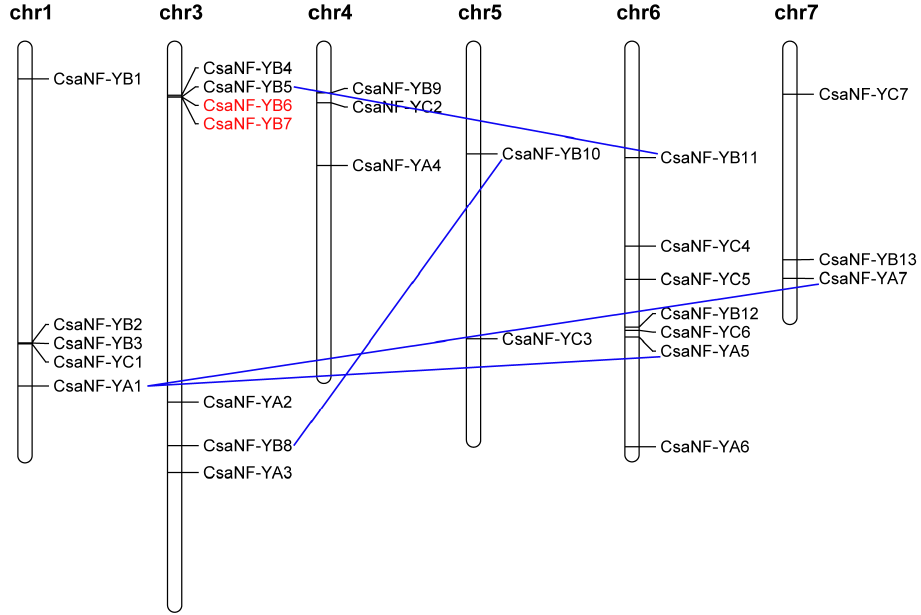
Figure 2. Chromosomal distribution of cucumber NF-Y genes. The chromosome number is indicated at the top, and chromosome 2 harbors no CsaNF-Y